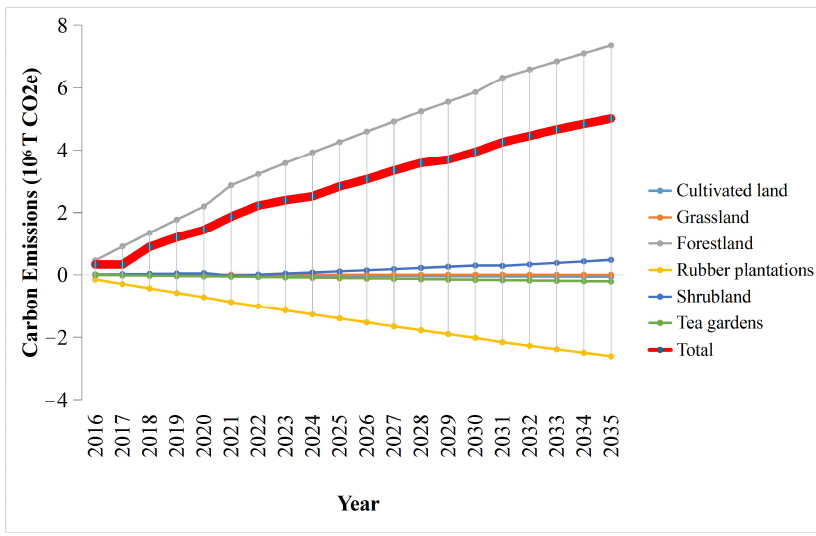
Figure 8. Reference levels in the Xishuangbanna